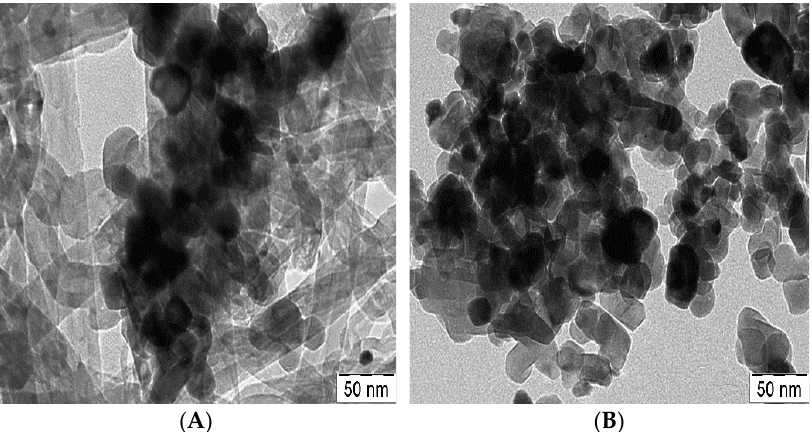
Figure 7. TEM micrographs for fresh ( A ) and used ( B ) 5Ni15YZr catalysts at a reaction temperature of 700 °C.